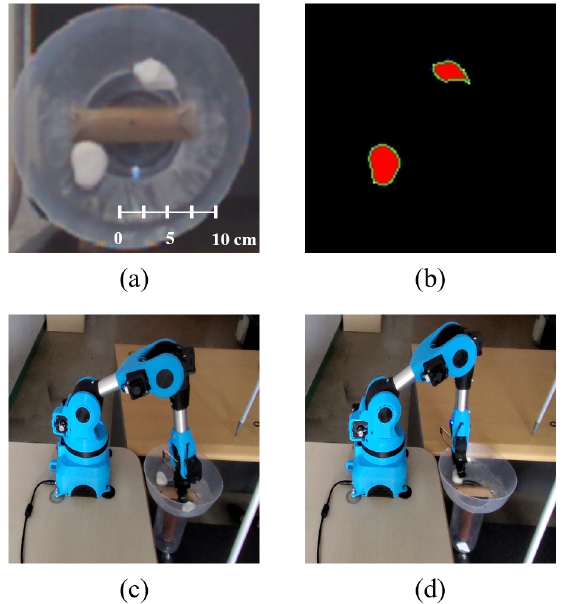
Figure 14. Experimental results obtained using the proposed smart hopper system in the case with two rocks above the hopper. ( a ) RGB image, ( b ) binary image of detected rock, ( c ) operation of the robot arm on the first rock, and ( d ) that on the second rock.